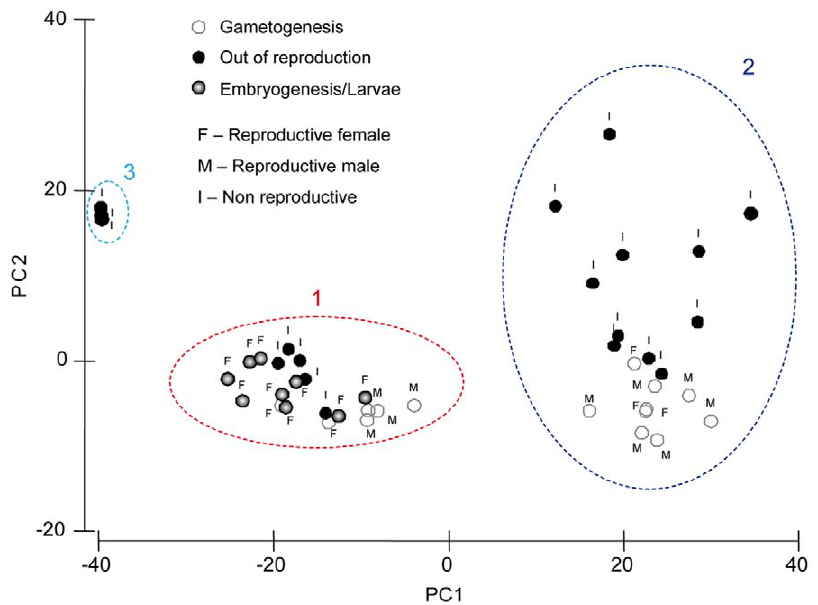
Figure 7. Relation between metabolic phenotypes and sponge reproductive status. The scatterplot of the metabolic fingerprint data set was analyzed by PCA. The representation factor is the reproductive stage with the indication of the sponge sexe. The PC1 explains 70.2% of variation and PC2 the additional 11.3%.